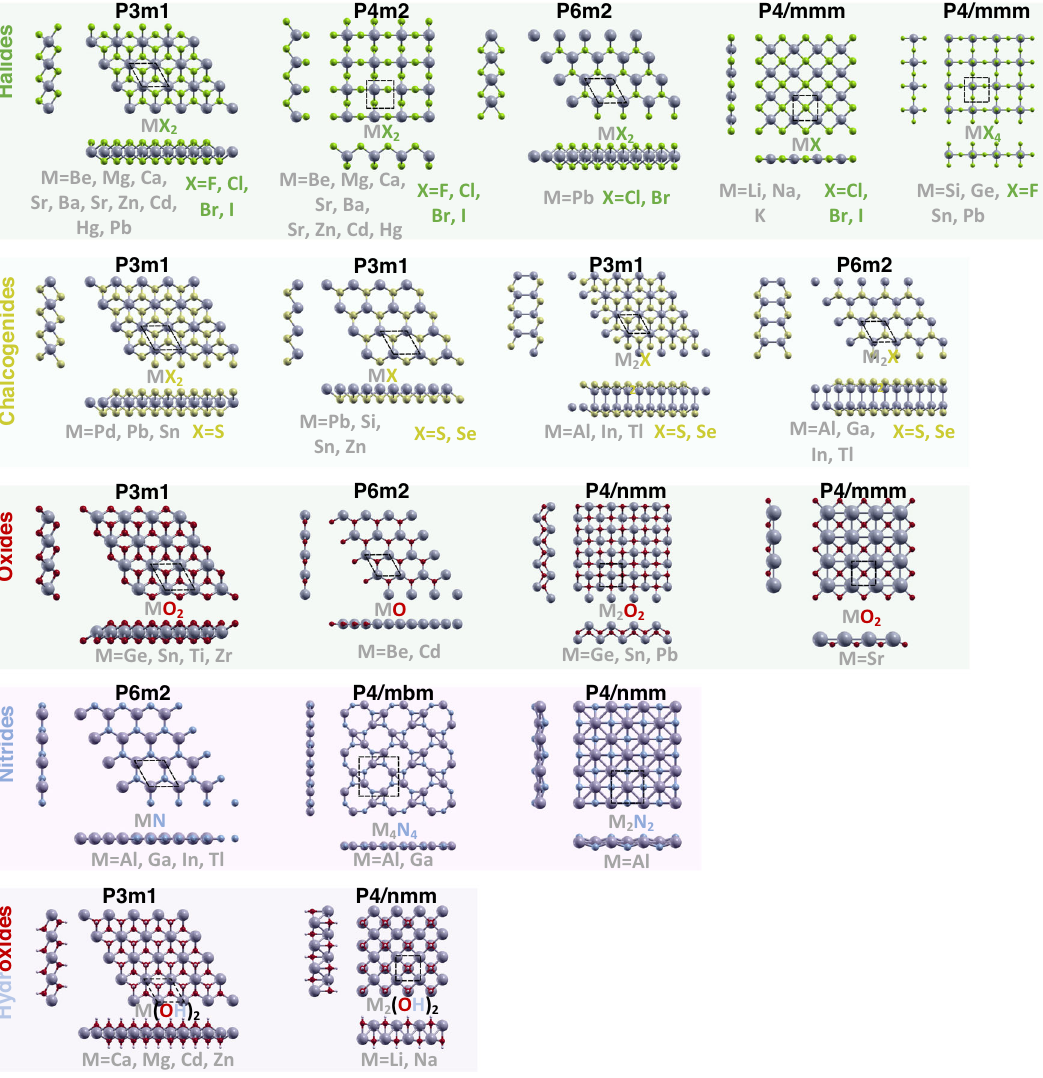
Fig. 2 Overview of the representative atomic structures of the 2DHDFM, sorted by chemical compositions and space groups. The chemical formula and the corresponding constituent elements of each atomic structures are provided, and the unit cells are marked out by the black dotted